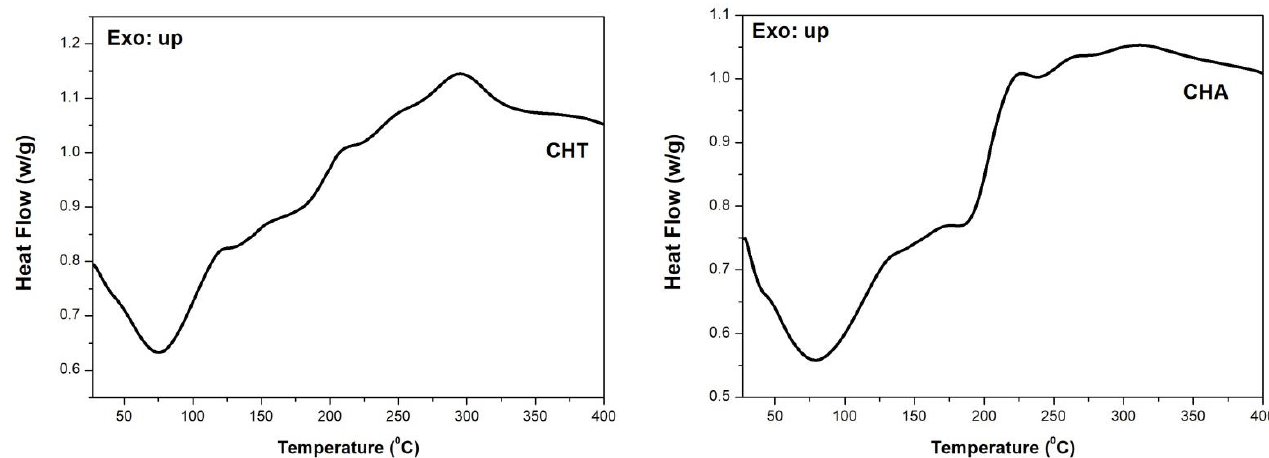
Figure 6. DSC thermogram of CHT and CHA.